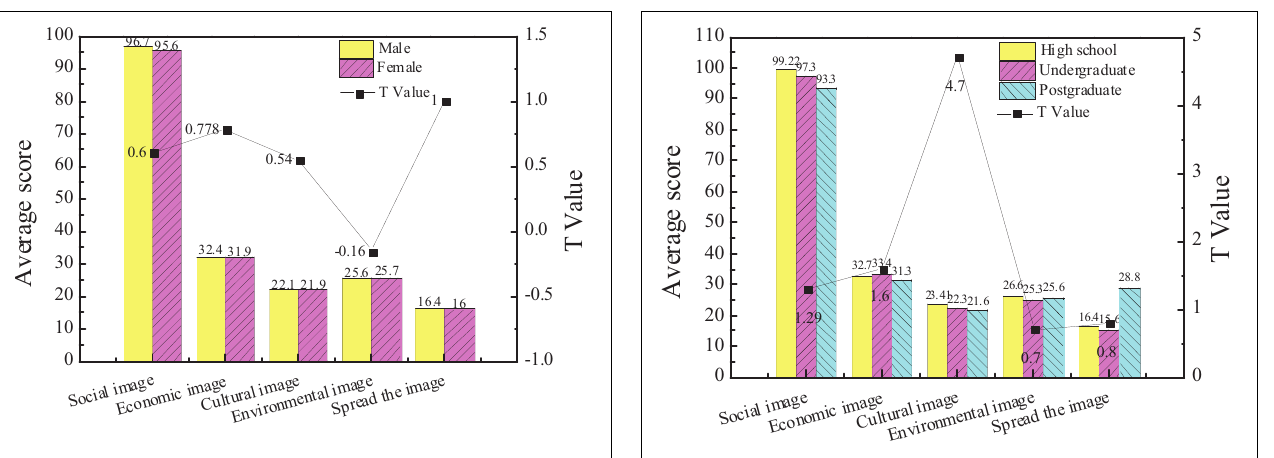
with undergraduate education is 22.3, and that of the subjects with graduate education is 21.6. The data show that there are different educational backgrounds to city images ( p <